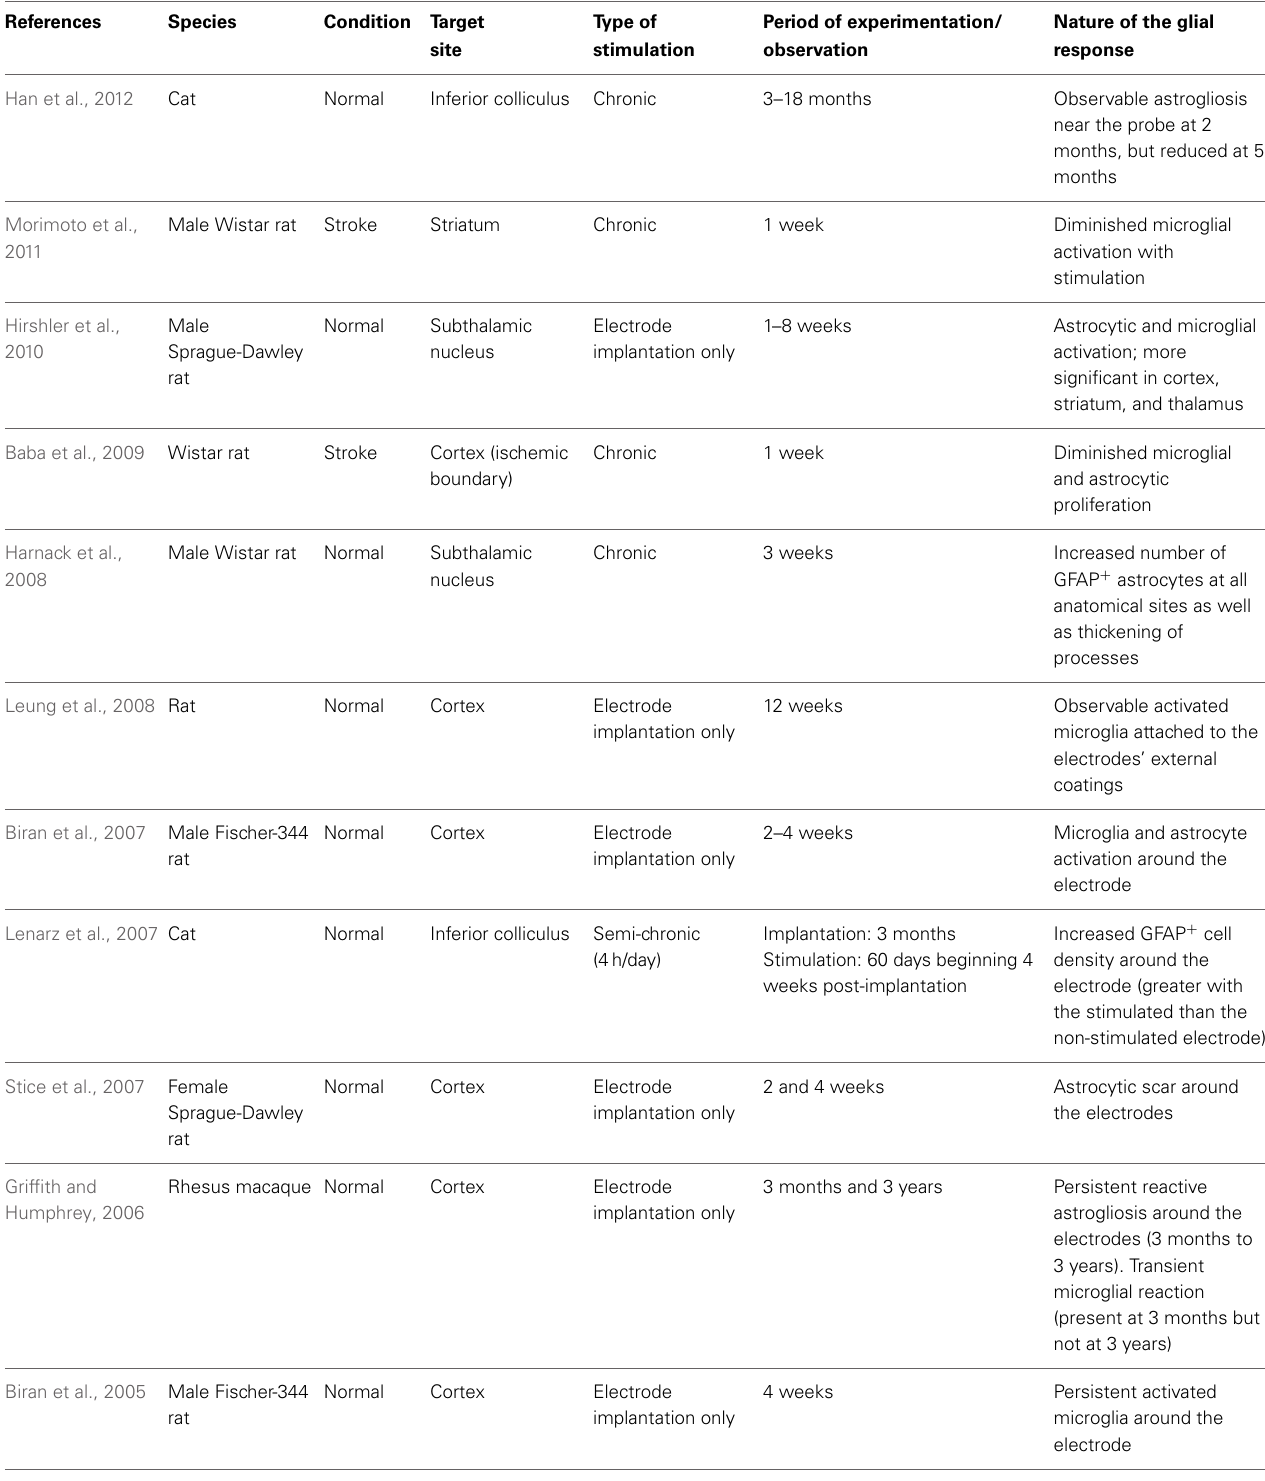
Table 1 | Glial response to DBS and electrode implantation in in vivo